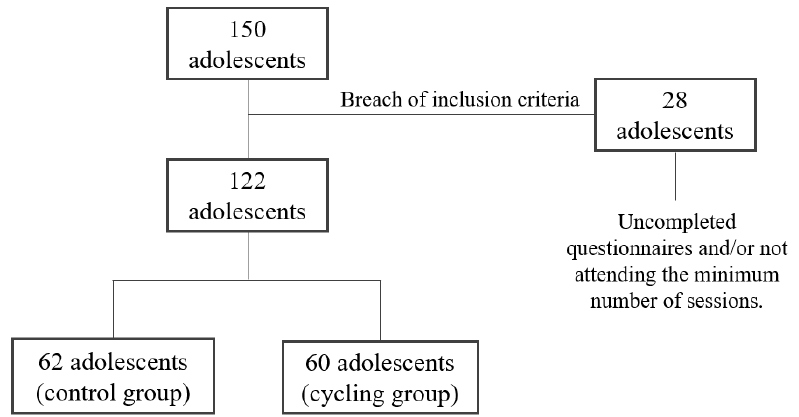
Figure 1. Flow chart of participants.